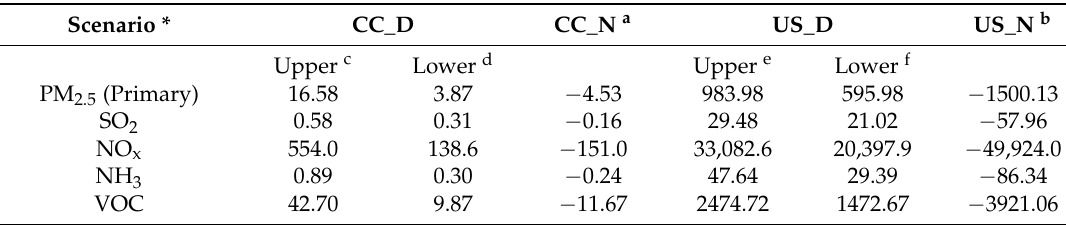
Table 2. Emission changes (tons/year) from the 2017 baseline for four scenarios evaluated in this study and used as the COBRA model